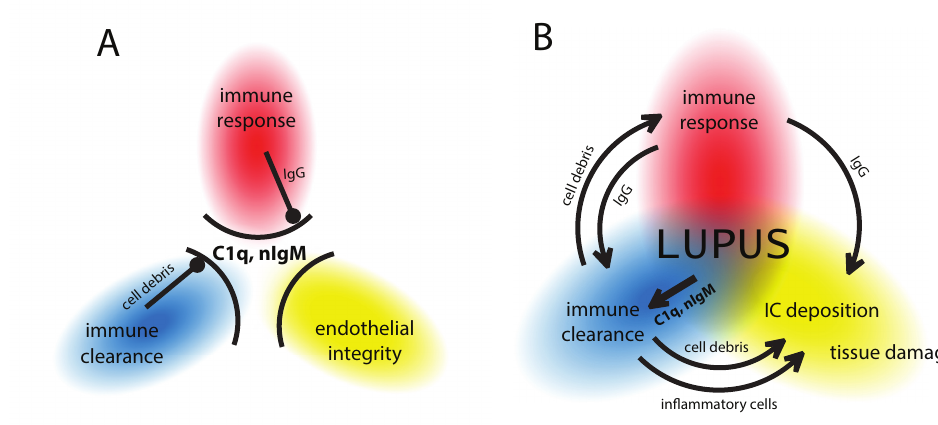
Figure 5. The lupus triangle in health and disease. C1q and natural IgM are gatekeepers that ensure innate immune clearance of apoptotic cellular debris and immune complexes, and also maintain endothelial integrity ( A ). Under physiological conditions these processes do not interfere with each other. Major abnormality in one or more of these processes, or combinations of minor abnormalities lead to imbalance, consumption of the gatekeepers, the breakdown of these gates and the development of lupus erythematosus ( B ). Depending on the contribution of these factors lupus will have different colors and shades, which define distinct disease entities or subtypes within such